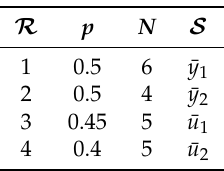
Table 4. Network parameters used in the